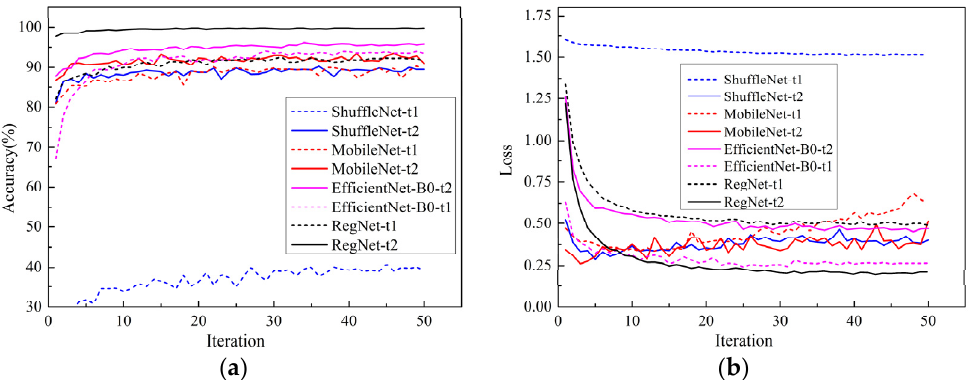
Figure 4. Comparison of two transfer learning methods: ( a ) the average accuracy curve; ( b ) the loss function curve.